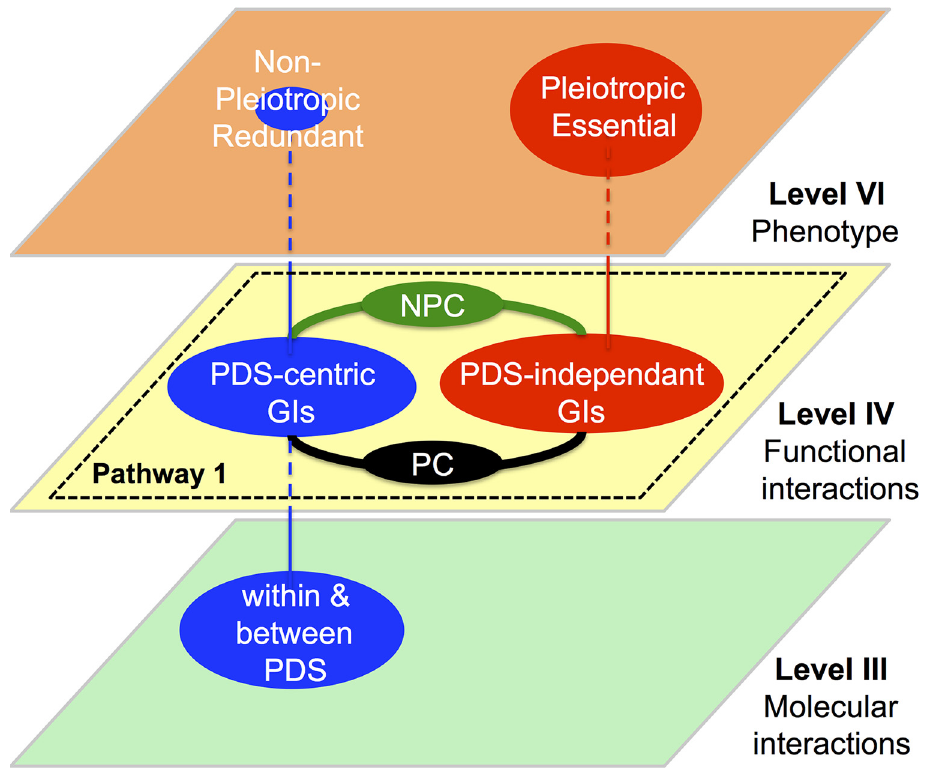
Fig 9. Structure and function of a GI-network within-pathway in Caenorhabditis elegans . Three abstraction levels are represented as plan from the bottom to top: Level III, level IV and level VI. PDS-centric interactions (C4 and C5 classes) are organized around Protein-protein interaction dense subnetworks (PDS) located at level III. They tend to involve non-pleiotropic and redundant genes (level VI). PDS-independent interactions (C1 and C2 classes) tend to involve pleiotropic and essential genes. GIs involving pleiotropic (PC; C6 class) and non-pleiotropic connectors/GI-Hubs (NPC; C3 class). They tend to link genes from an average to a high range of pleiotropy and to an average to a low rang of pleiotropy respectively.